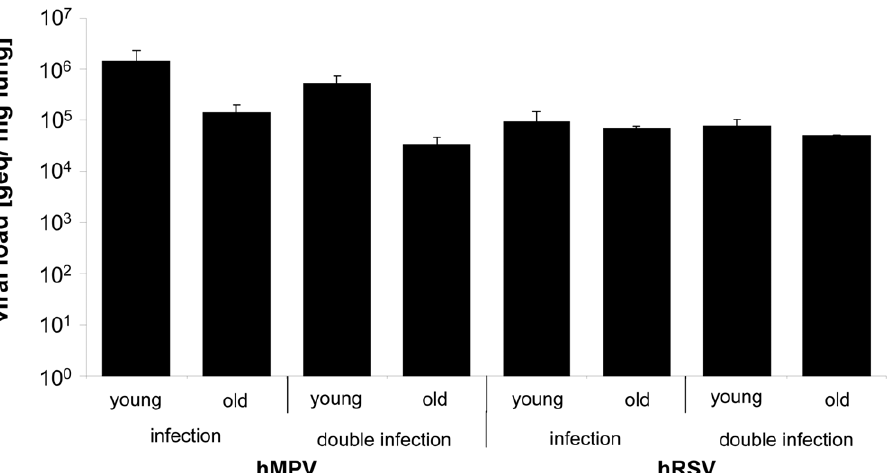
Figure 3. Viral load of lungs after infection. Viral load of lungs obtained from 4–6 weeks and 19 months old BALB/c mice after infection with RSV, HMPV or double infection: 4–6 weeks and 19 months old BALB/c mice were infected with 2 6 10 7 geq RSV or HMPV, or co-infected with 1 6 10 7 geq of each virus. Untreated animals, animals anesthetized and treated with cell culture supernatant or PBS or only anesthetized served as controls. Mice were killed by cervical dislocation and the lungs were removed, homogenised and viral RNA was extracted. The number of genome equivalents was estimated by qRT-PCR (n=3–5, values are shown as mean 6 standard deviation).